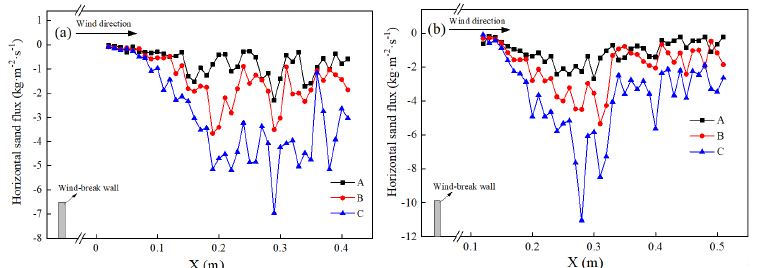
Figure 11. Horizontal sand flux ( u ∗ = 0.9701 m/s). ( a ) H = 0.05 m (above the track). ( b ) H = 0.10 m (above the track).